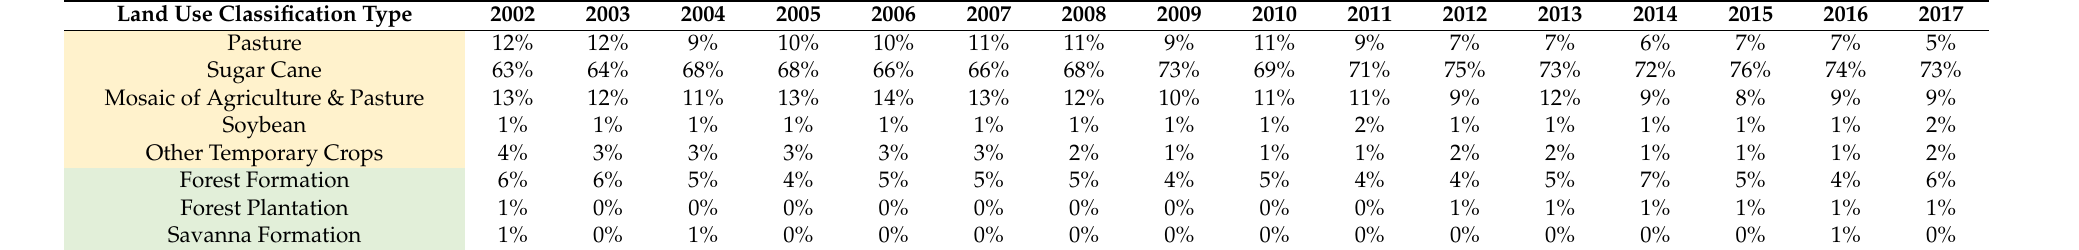
Table 3. Most commonly burned pixels by classification type between 2002 and